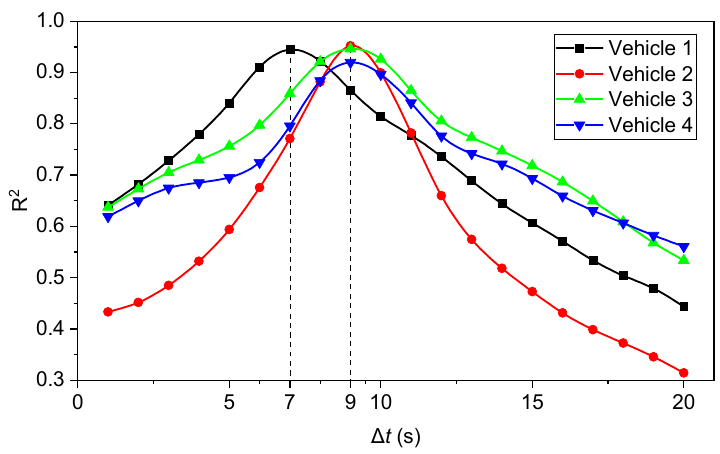
Figure 9. The correlation coefficient vs. delay time.